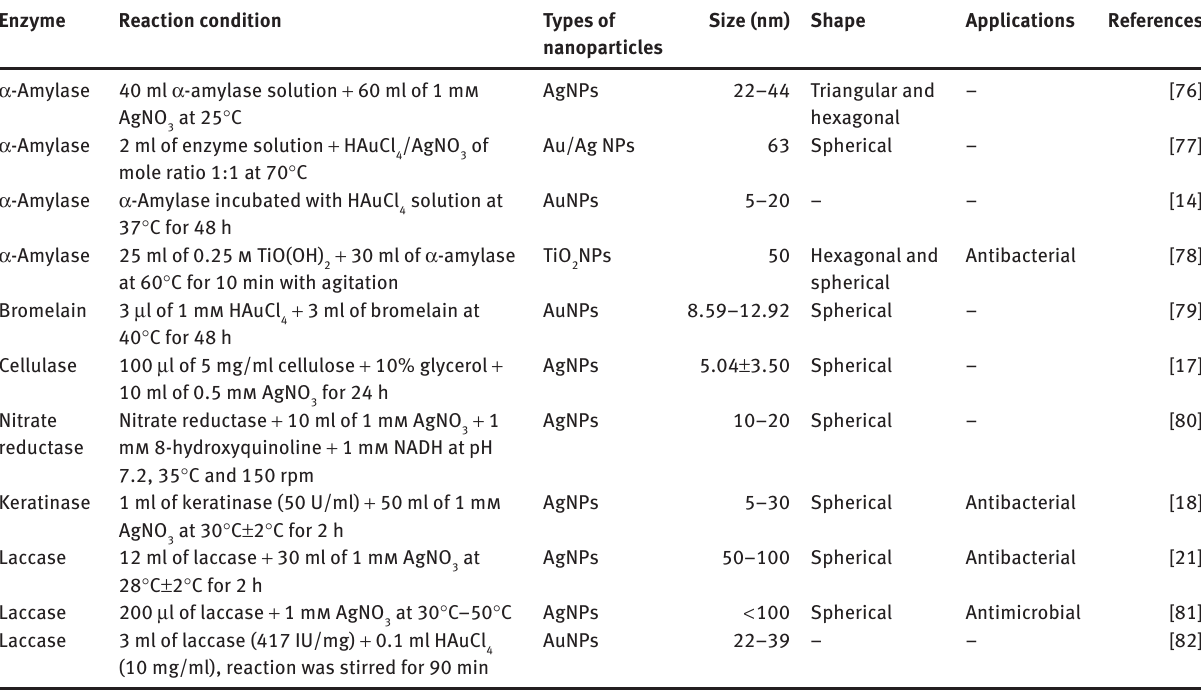
Table 2: Synthesis of nanoparticles by enzymes. Enzyme Reaction